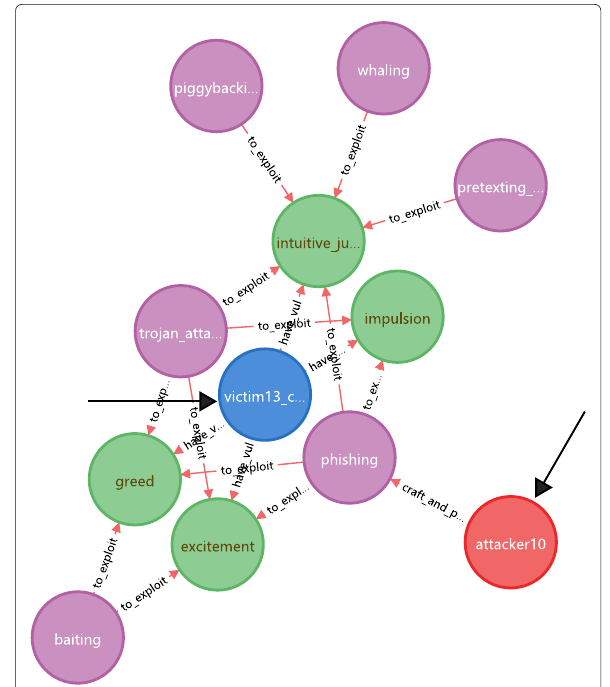
Fig. 25 For specific attacker and victim, find potential attack paths and